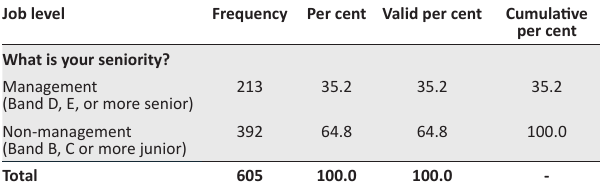
TABLE 4: Participants’ seniority.